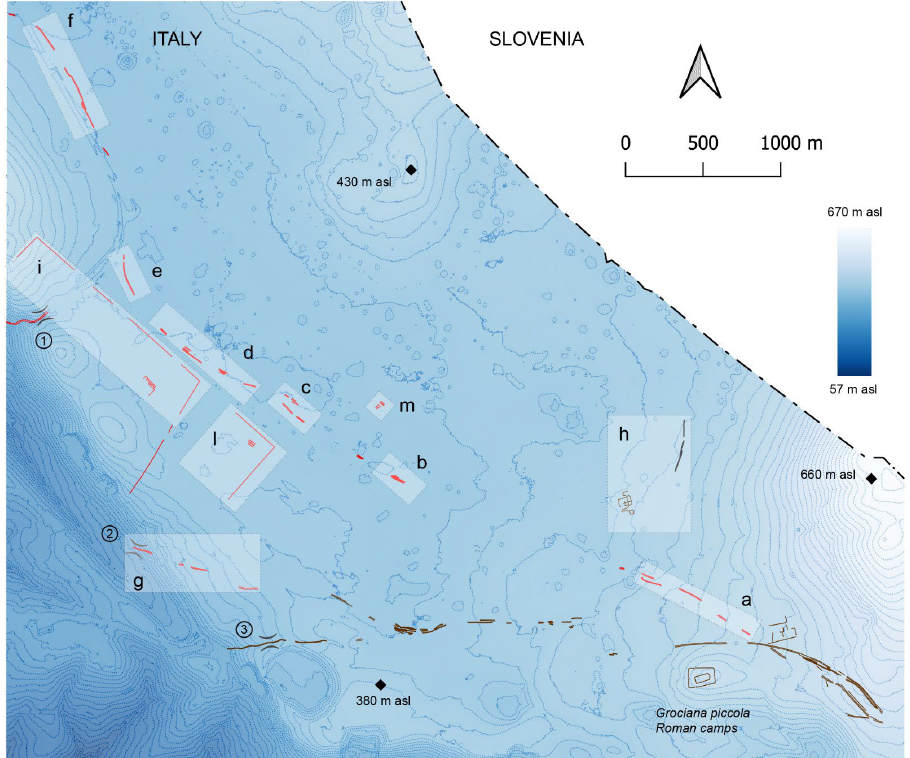
Figure 2. ALS-derived DTM with 10 m-contour lines of the investigated area showing the main identified Roman archaeological features (red lines). Those already detected and studied by Bernardini et al. [9] are shown in dark brown. 1 : Monte Spaccato pass; 2 : point where the road from Grociana piccola to Tergeste leaves the Karst plateau; 3 : pedestrian path known as scala delle vacche .